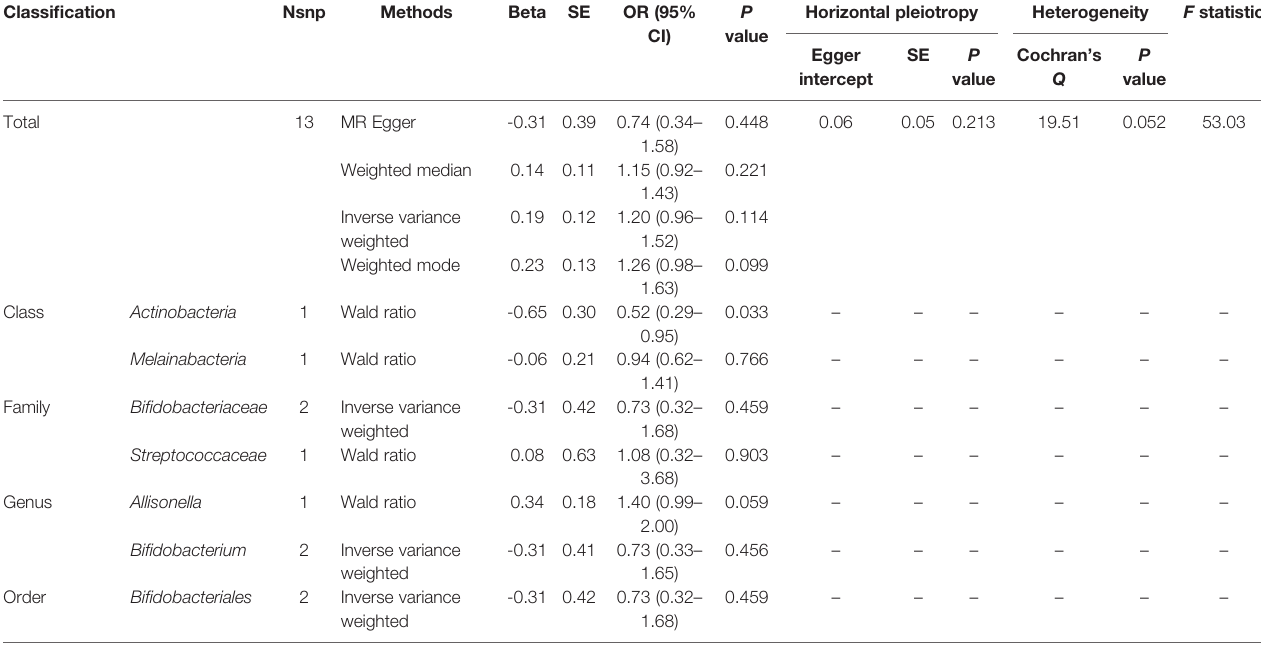
TABLE 3 | MR results of causal links between gut microbiome and SLE risk ( P < 5 × 10 -8